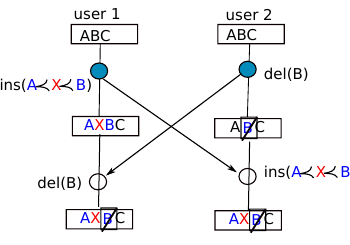
Figure 8. Integration in